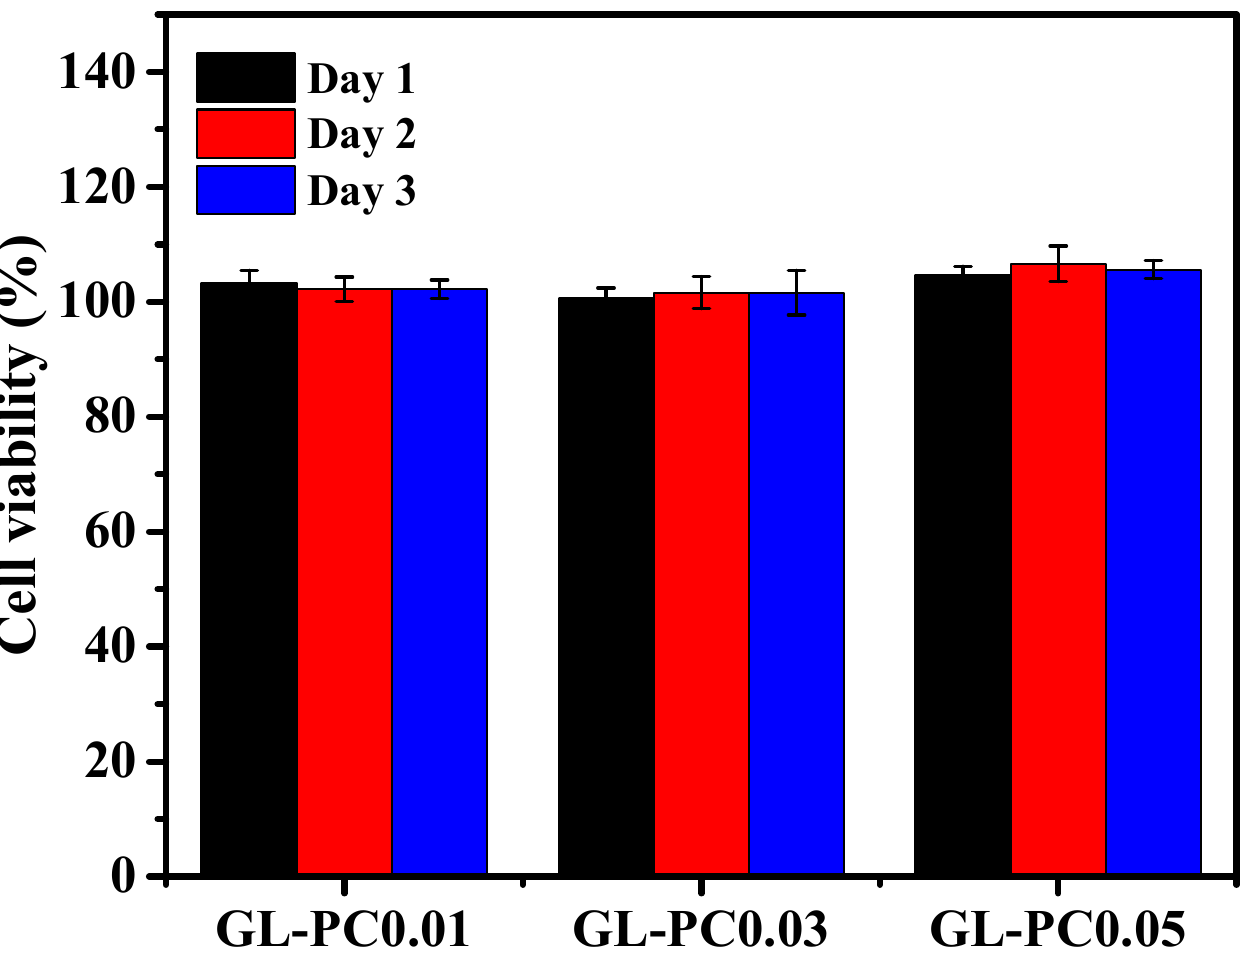
Figure 6. Cell viability BSCs (isolated from 30-month-old-Korean male cattle) cultured on GL-PC scaffolds using PrestoBlue assay.